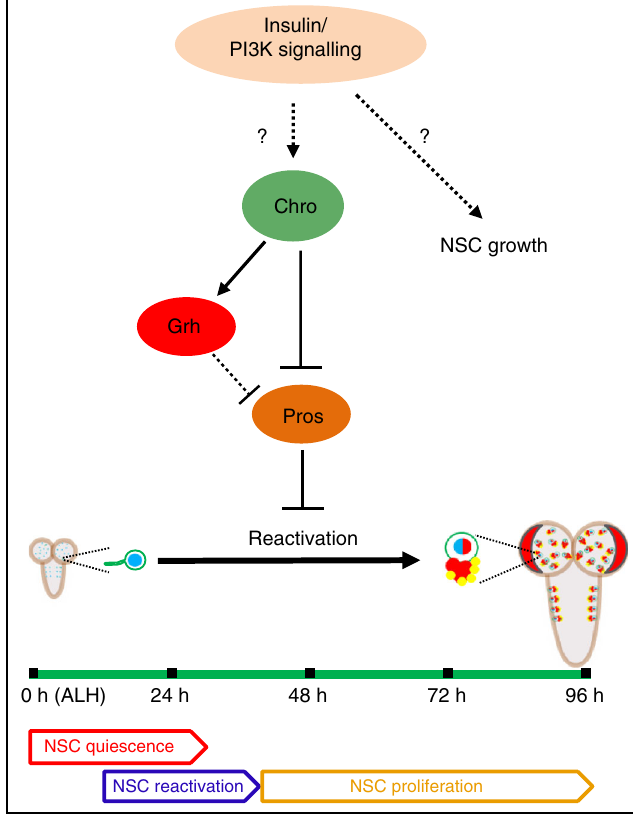
Fig. 5 A working model. Chro functions downstream of insulin-PI3K signalling pathway and regulates the expression of Grh and Pros in NSCs during the transition from quiescence to